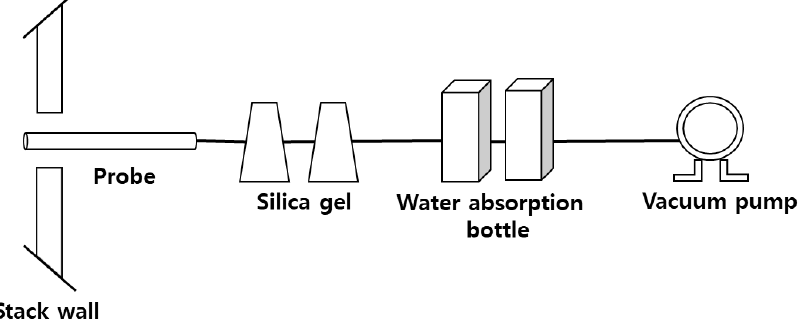
Figure 2. Schematic of the field setup for ammonia sampling at LNG power plant.